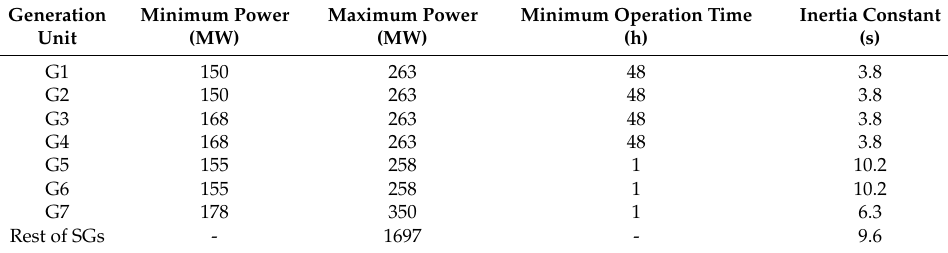
Table 1. Technical parameters of main synchronous generators (SGs).